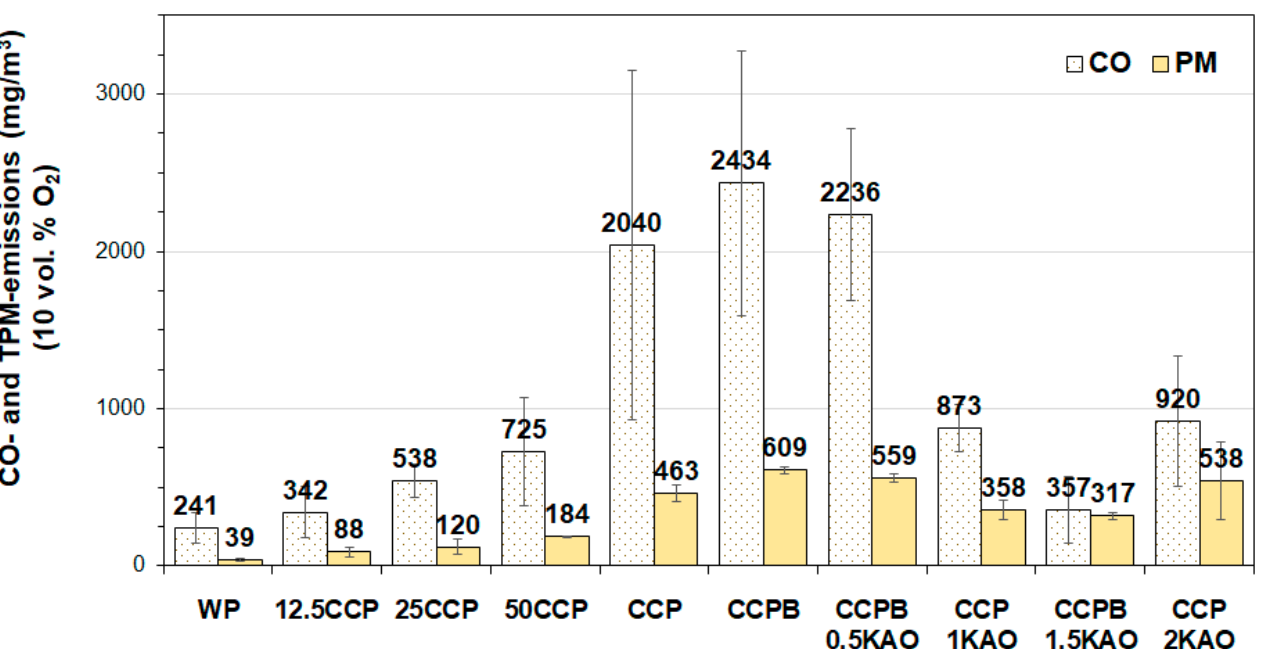
Energies 2021 , 14 , x FOR PEER REVIEW 11 of 24